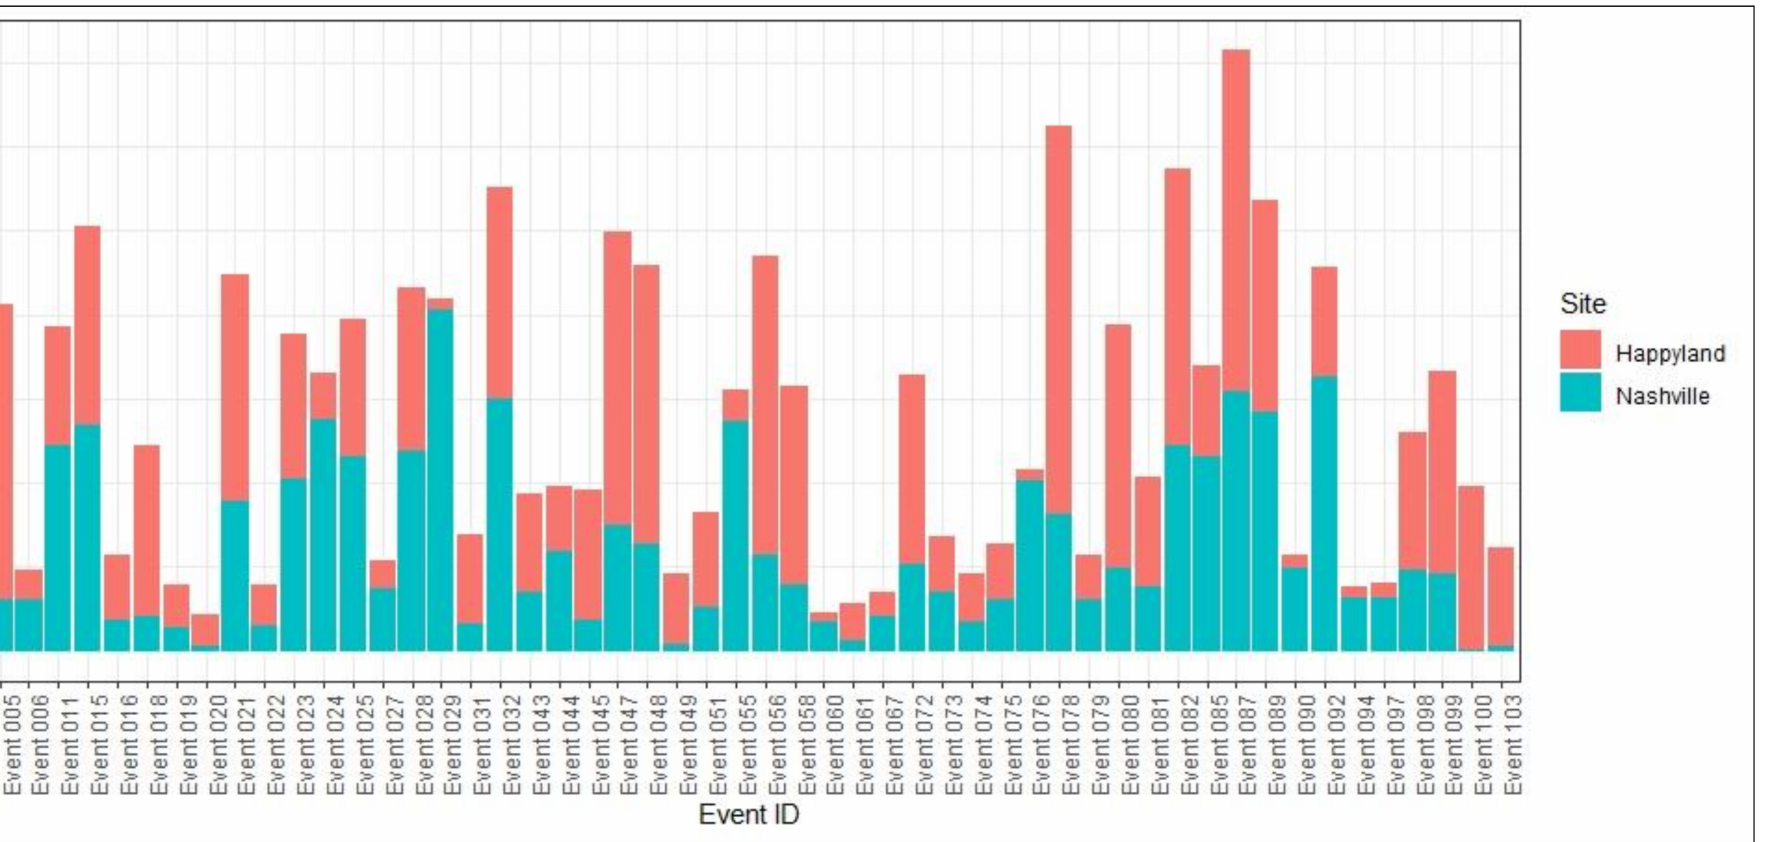
Figure A3. Total precipitation at Happyland and Nashville sites based on common 52 events that occurred during the monitoring